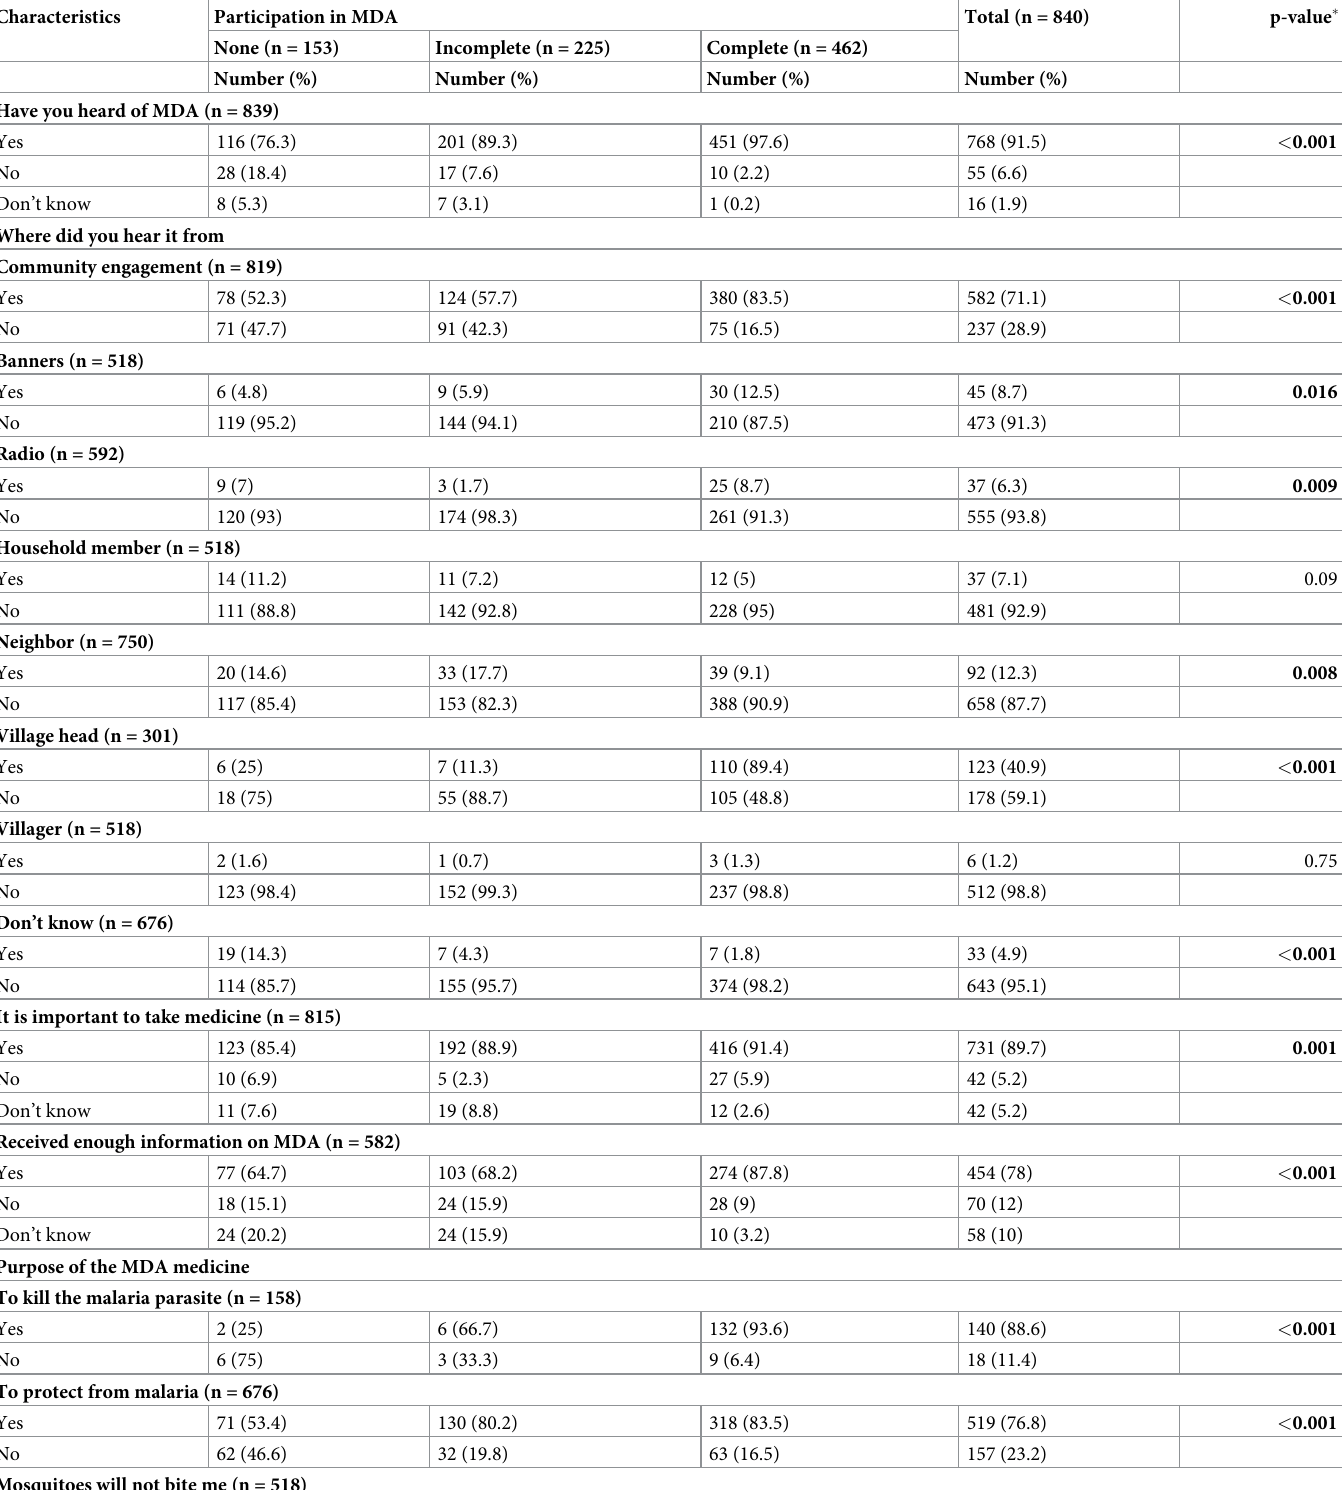
Table 6. Knowledge, perceptions and experiences related to MDA (n = 840).